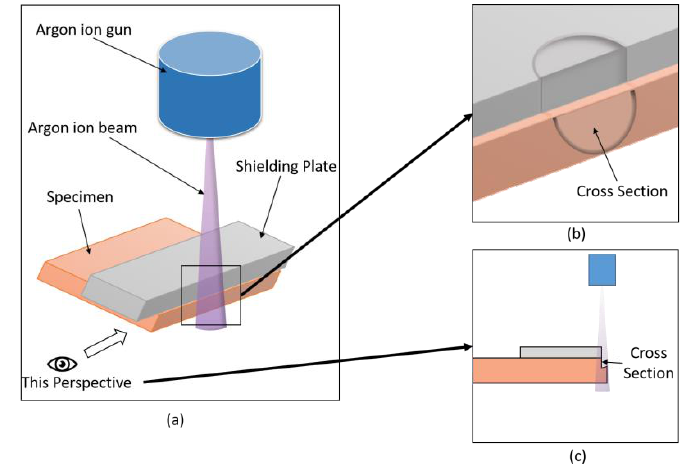
Figure 2. Flow chart of sample preparation and characterization.